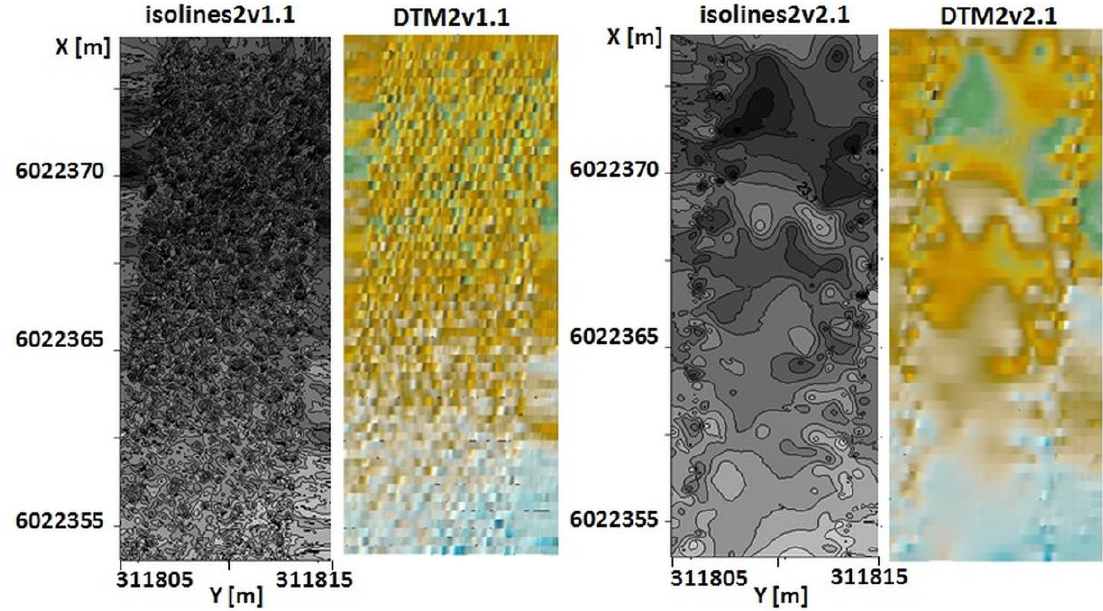
Figure 10. Isolines2v1.1 and DTM2v1.1, and isolines2v2.1 and DTM2v2.1 generated for strip 2 (p 2 ) by methodologies v1.1 and v2.1, respectively.